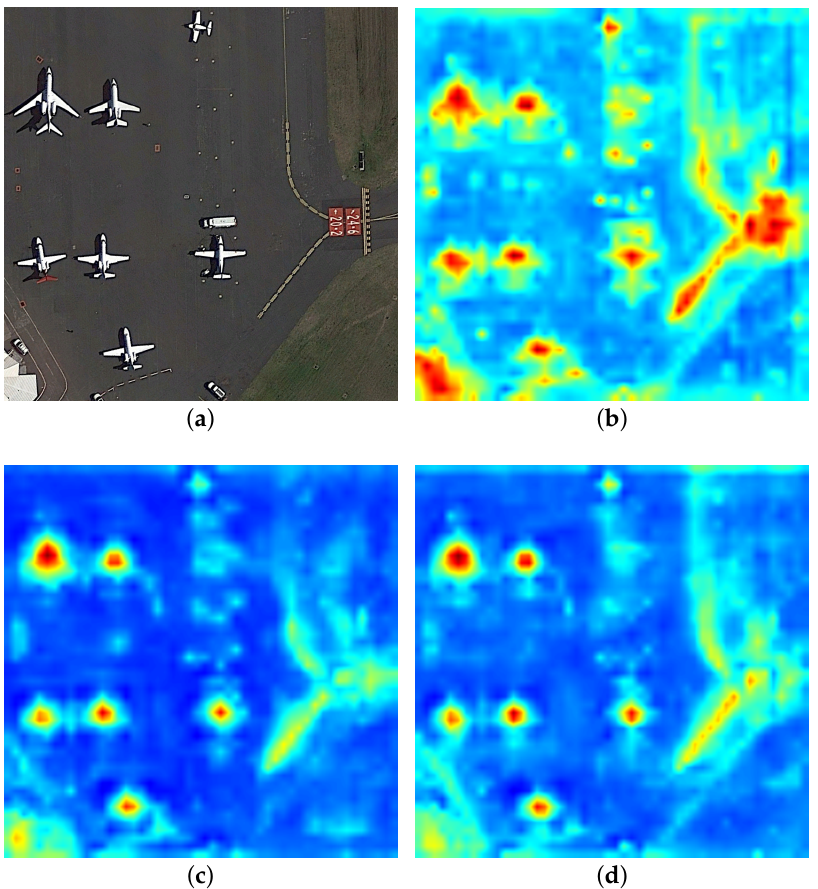
Figure 1. Visualisation of middle layer feature maps for different teacher networks. ( a ) Input image, ( b ) feature map of ResNet101, ( c ) feature map of ResNext32, ( d ) feature map of